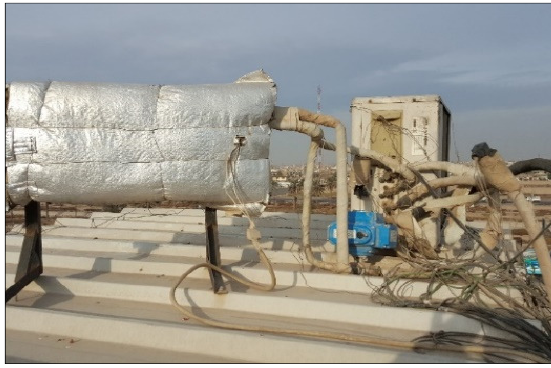
Fig. 3. Outdoor components.